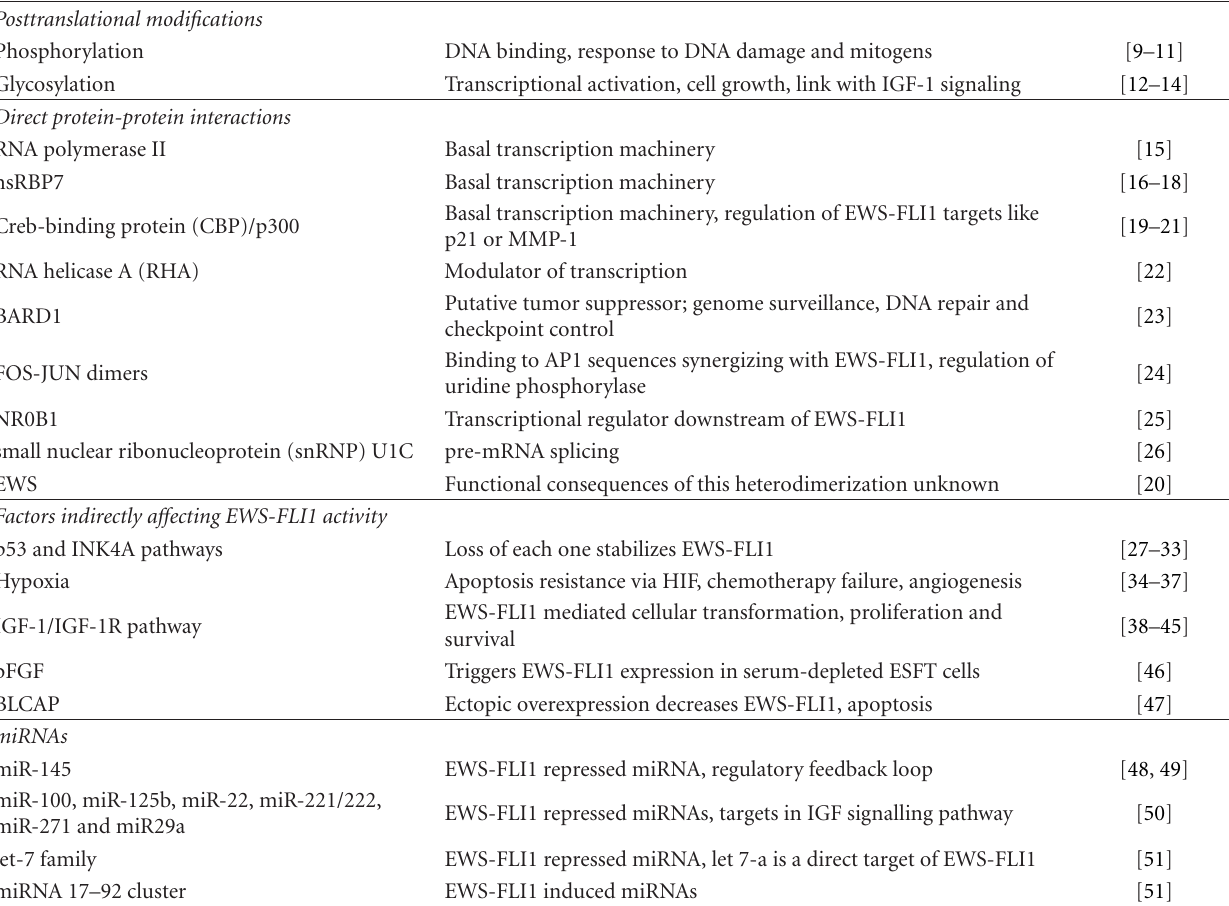
Table 1: Factors influencing EWS-FLI1 activity and/or